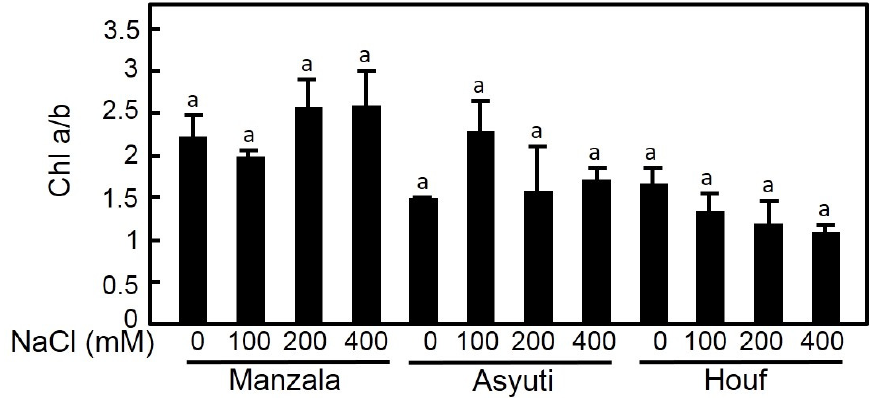
Figure 9. The e ff ects of di ff erent salt concentrations (0, 100, 200 and 400 mM NaCl) on Chl a / b in Z. coccineum for 45 days. Value represents the mean of 5 replicates ± standard error, p -value < 0.05. For variables denoted with the same letter, the di ff erence is not statistically